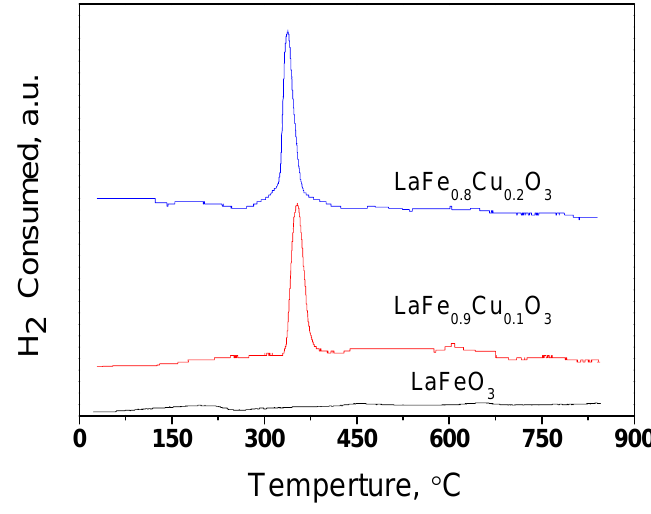
Cu O (x=0, 0.1, 1-x x 3